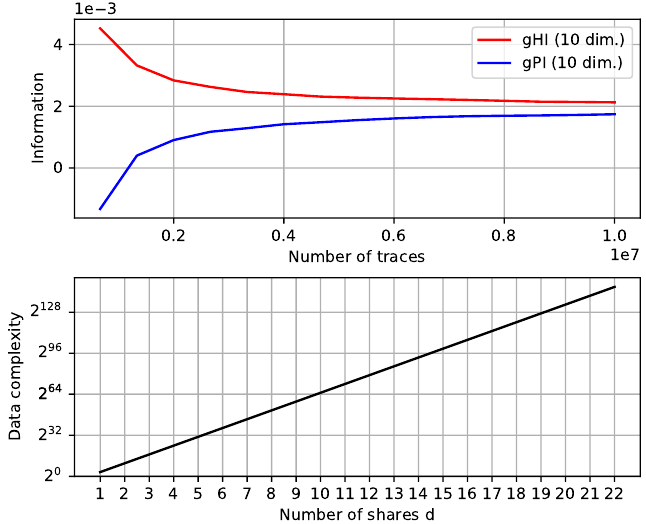
Figure 11: Top: convergence of IT metrics. Bottom: security